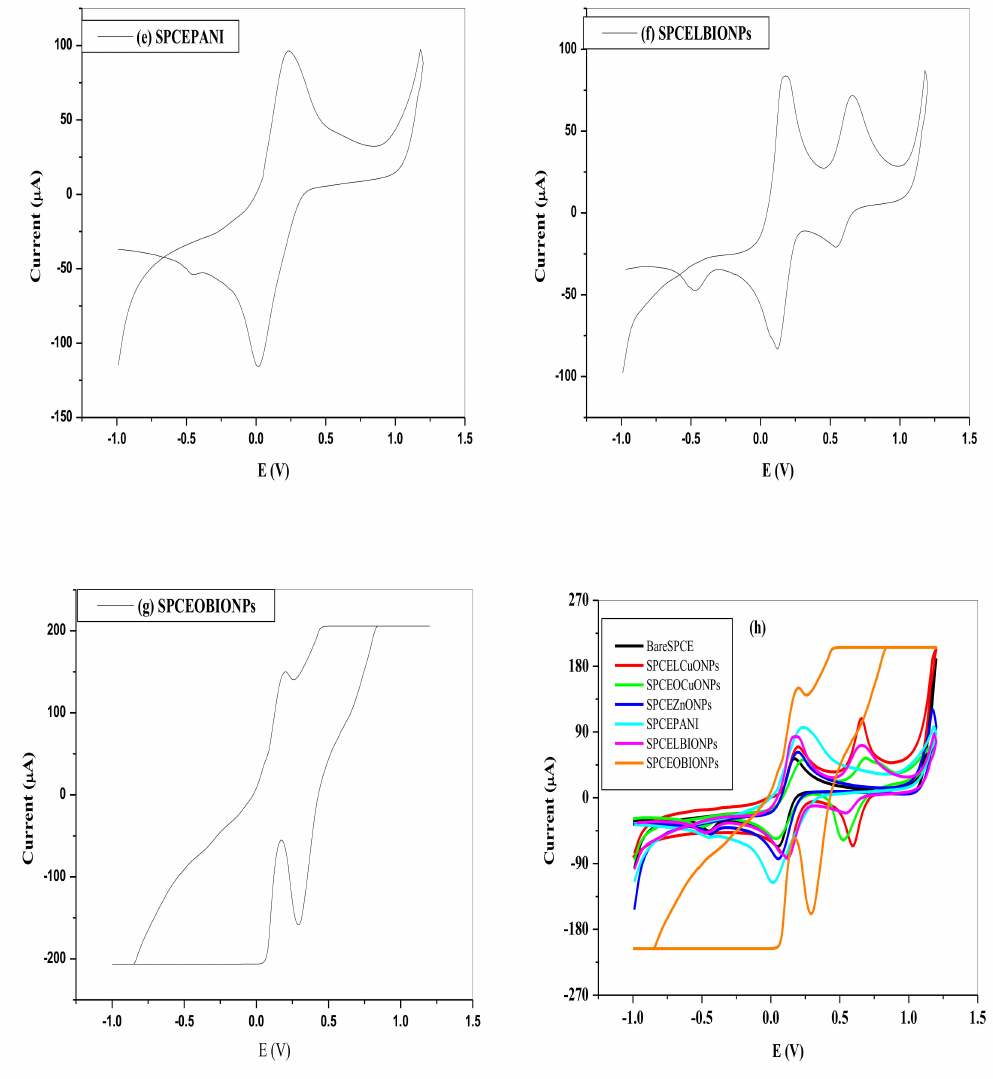
Figure 5. Individual and CV comparison of 0.01 M [Fe(CN) 6 ] 4 − in 0.1 M KCl at pH ≈ 7 on the ( a ) bare SPE, modified ( b ) SPCE/LPE/CuONPs ( c ) SPCE/OPE/CuONPs ( d ) SPCE/CPE/ZnONPs, ( e ) SPCE/PANI, ( f ) SPCE/LPE/BiONPs, ( g ) SPCE/OPE/BiONPs, and ( h ) modified SPCE (scan rate = 0.01 V/s, Potentials vs.